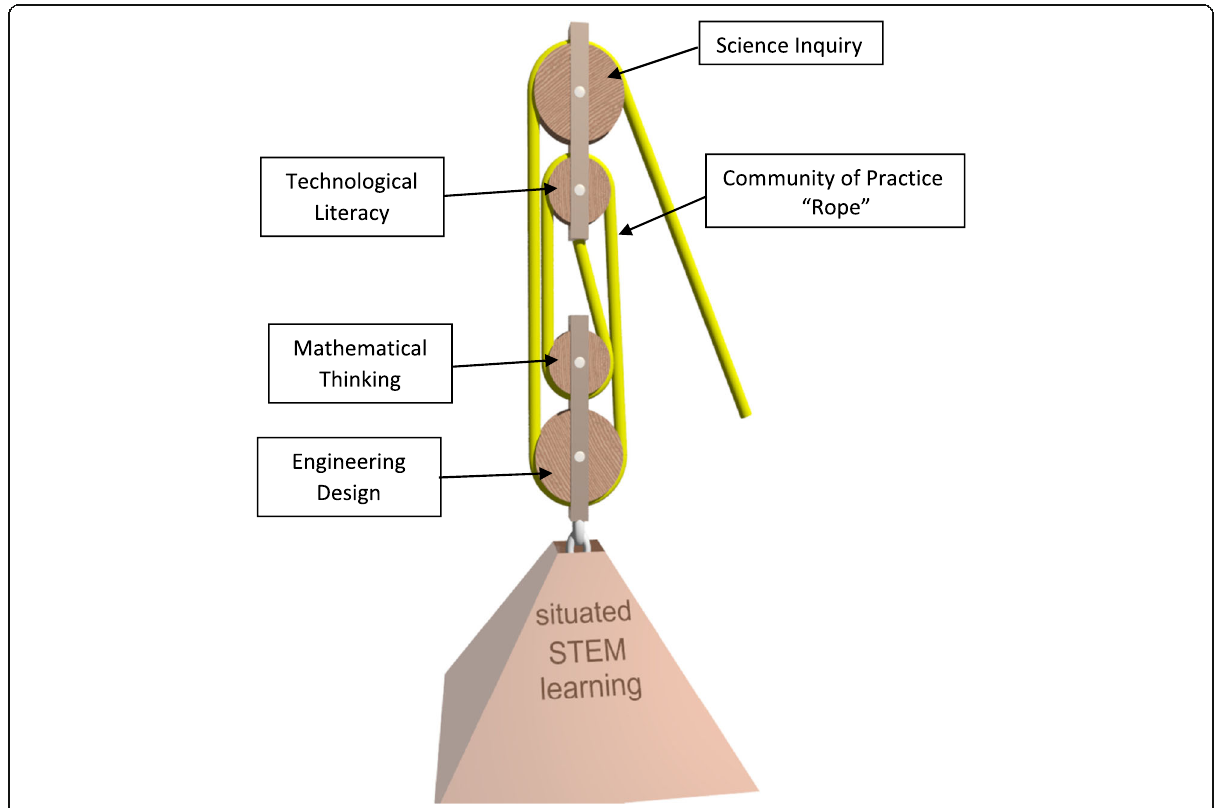
Fig. 1 The conceptual framework for STEM learning (Kelley & Knowles, 2016, p.